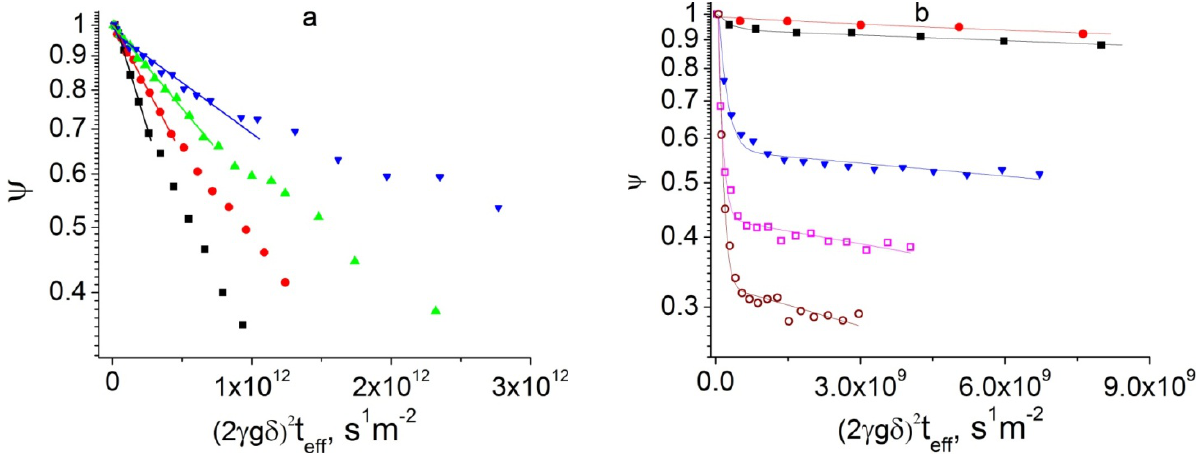
Table 2. Results of fitting of the initial parts of the attenuation curves in Figure 5a by Equation (1), n = 1 and the corresponding effective diameters of the particle components surrounded by transport barriers Equation